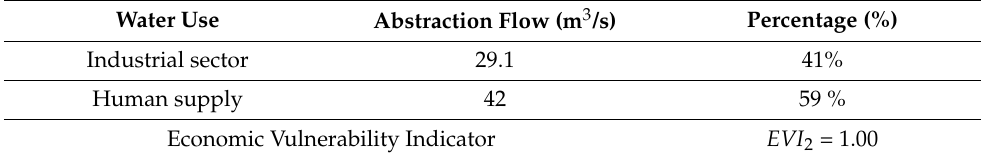
Table 19. Economic vulnerability indicator ( EVI 2 ) application.